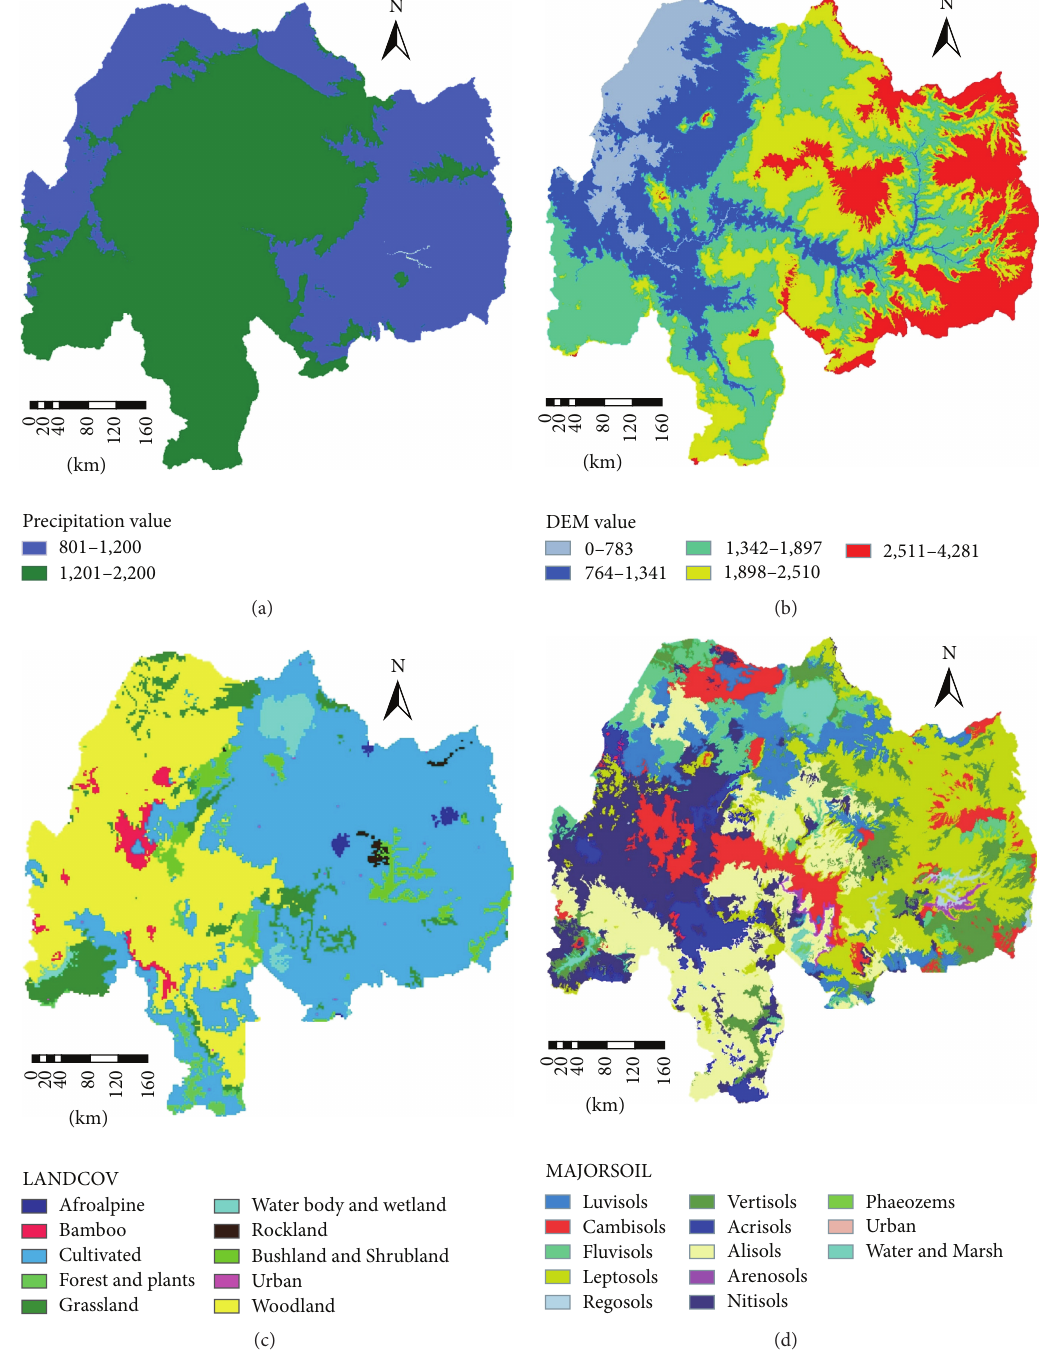
Figure 1: Spatial datasets used for the water harvesting suitability study of the Upper Blue Nile Basin: (a) annual rainfall (mm), (b) DEM (meters above sea level), (c) land cover map, and (d) soil